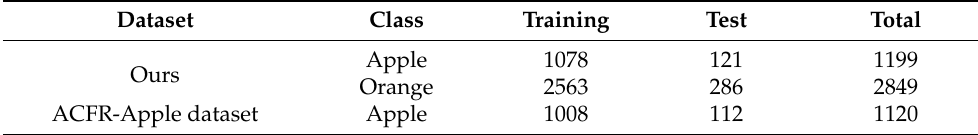
Table 1. The detailed partition of fruit images for the fruit detection model.